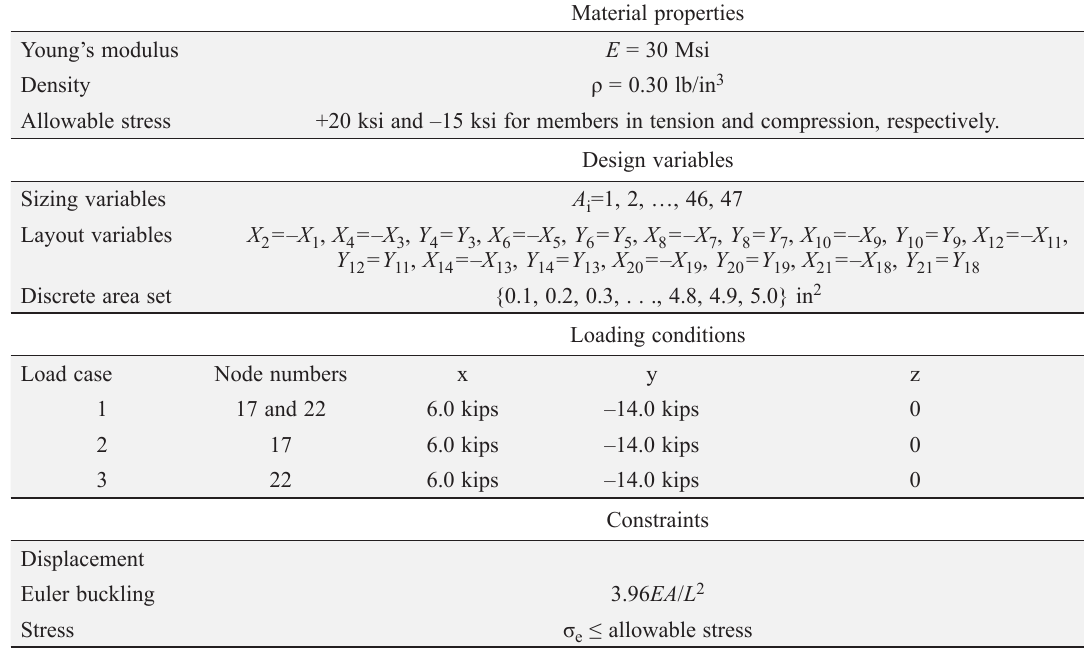
Table 11. Input data for the planar 47-bar truss